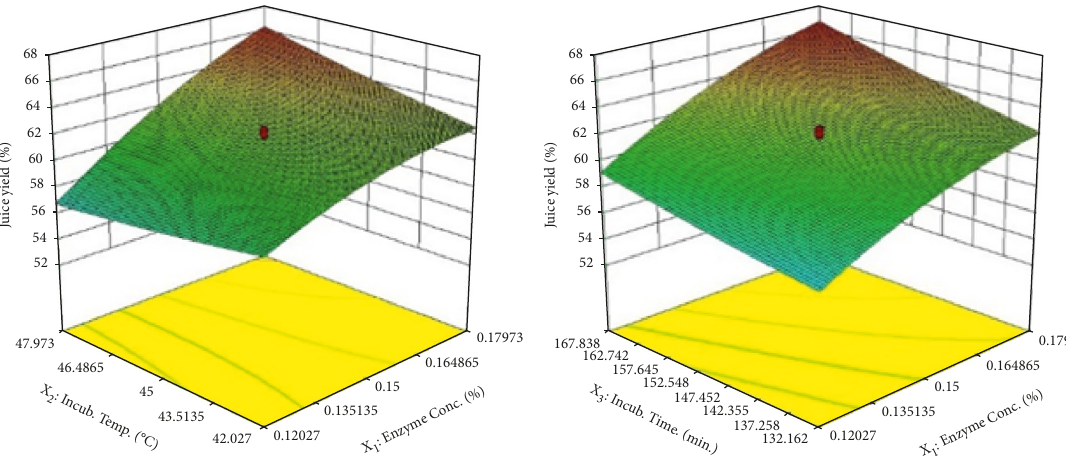
Figure 2: 3D graph plots displaying the linear and interactive effect of factors on juice